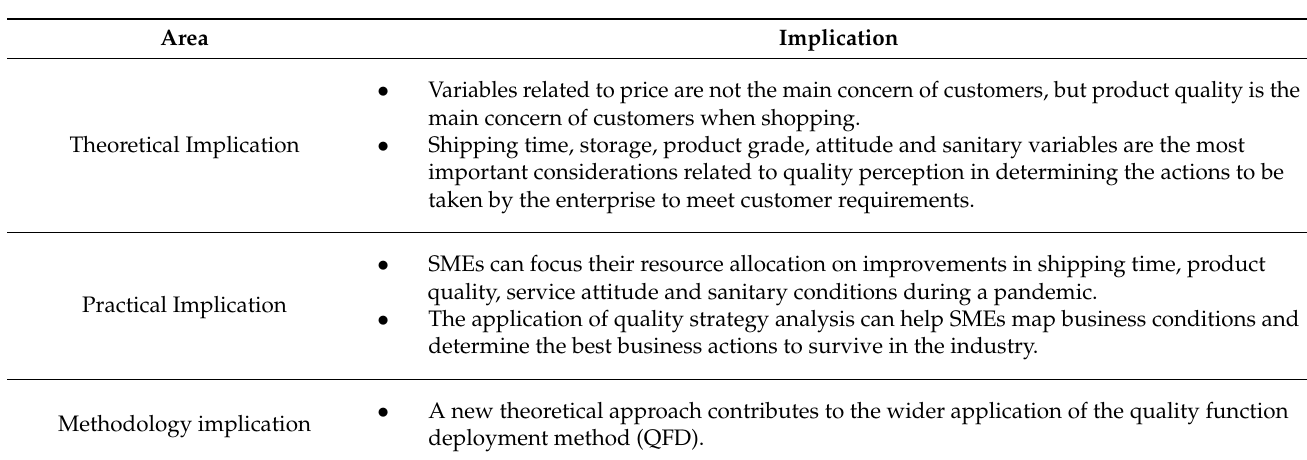
Table 5. Summary table of research